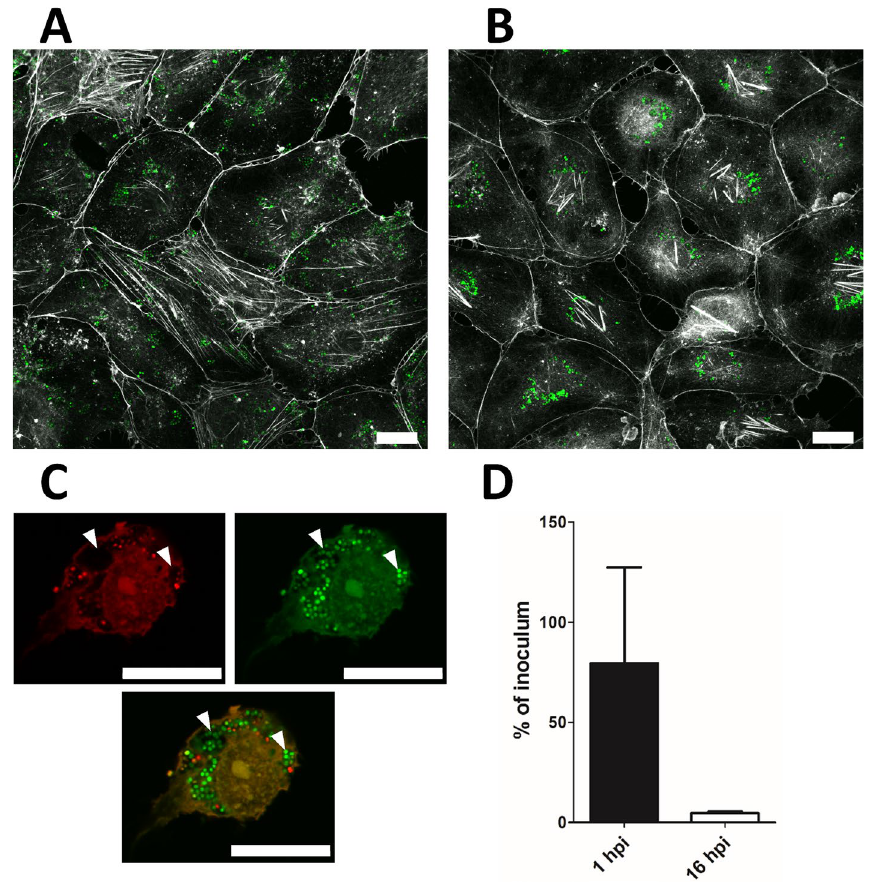
Figure 2. Infected HUVECs were visualized by confocal laser scanning microscopy ( A–C ) and quantified for bacterial numbers by plating ( D ). ( A–B ) GFP-producing S. aureus (green)have invaded the majority of the HUVECs (white, Acti-stain 670) at both 1 hpi ( A ) and 16 hpi ( B ). ( C ) At 16 hpi, bacteria are localised inside vacuolar compartments. Cells were stained with LIVE/DEAD cell viability stain (propidium iodide, red, and SYTO9, green). ( D ) Number of colony-forming units of S. aureus at 1 hpi and 16 hpi compared to the inoculum. Scale bars in ( A – C ) indicate 20